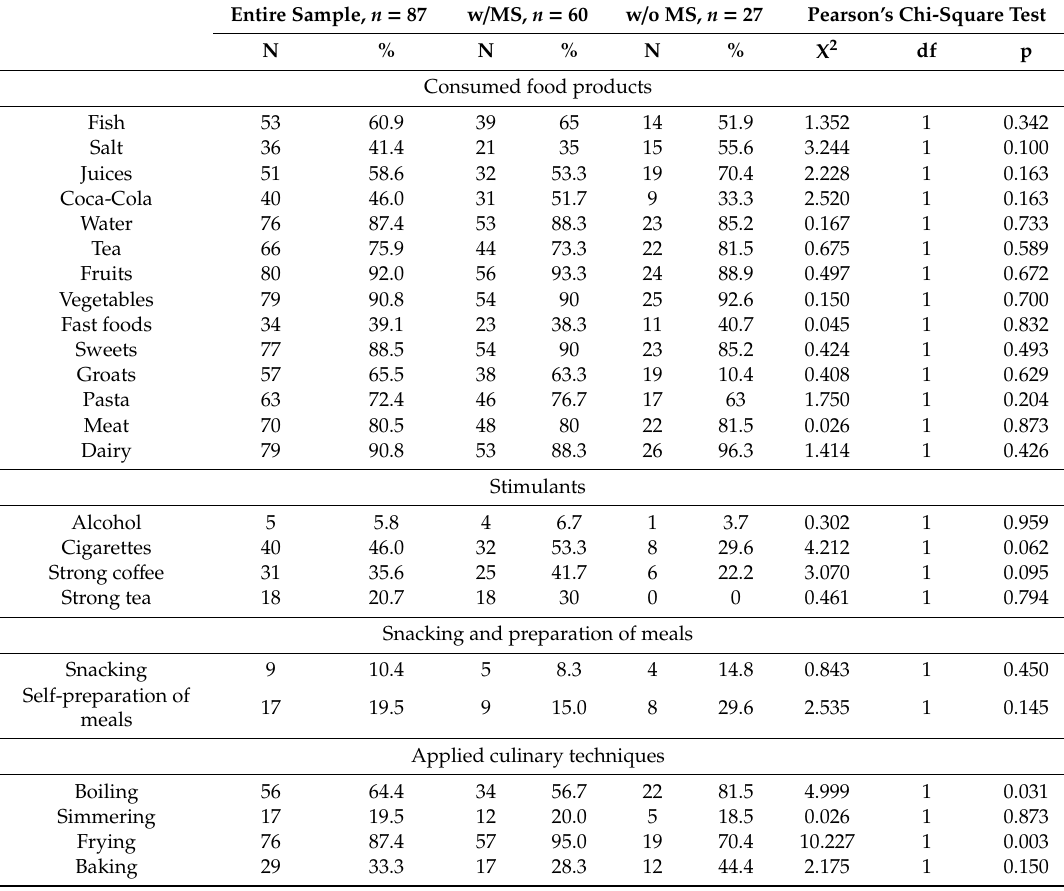
Table 2. Comparison of selected eating behaviors in patients with and without MS